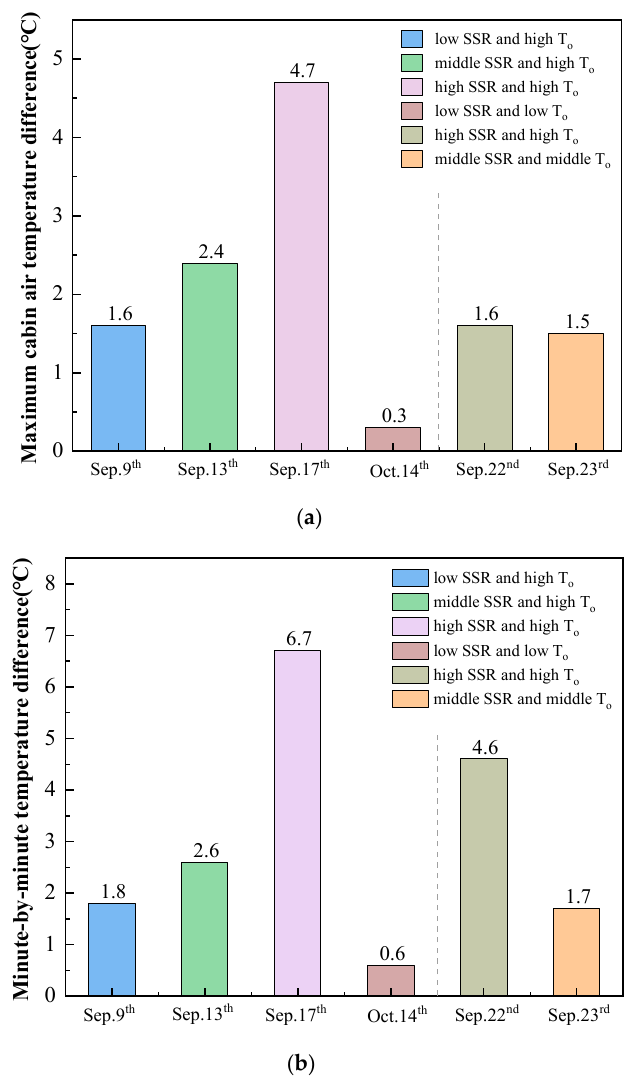
Figure 8. Cabin air temperature difference between two vehicles under different ambient conditions: ( a ) difference of maximum temperature; ( b ) minute-by-minute maximum difference of temperature.